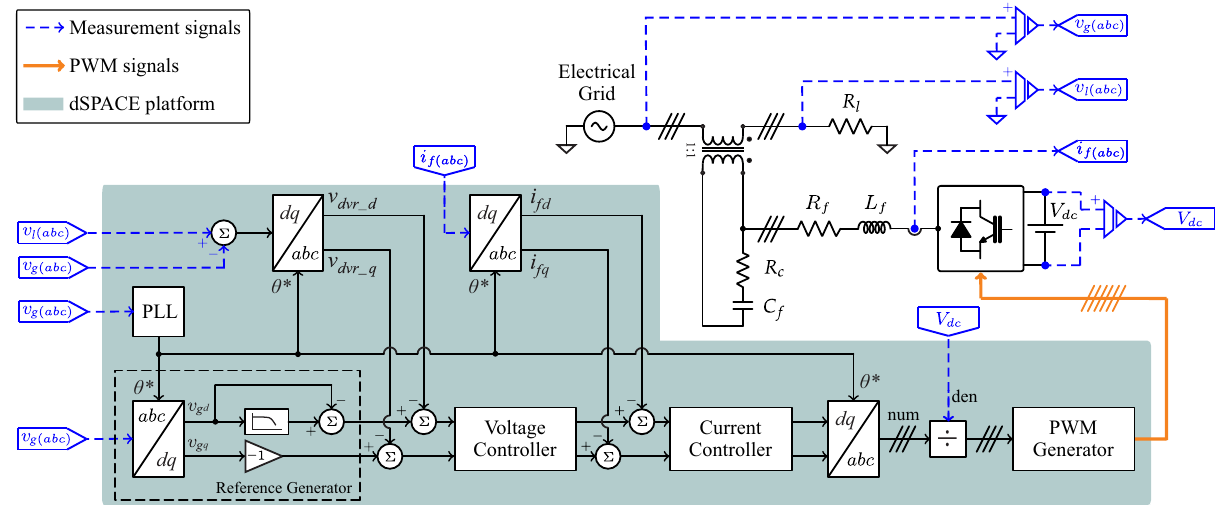
Figure 4. Block diagram of the complete control system used to evaluate the ability of the conventional DVR of attenuating zero-sequence